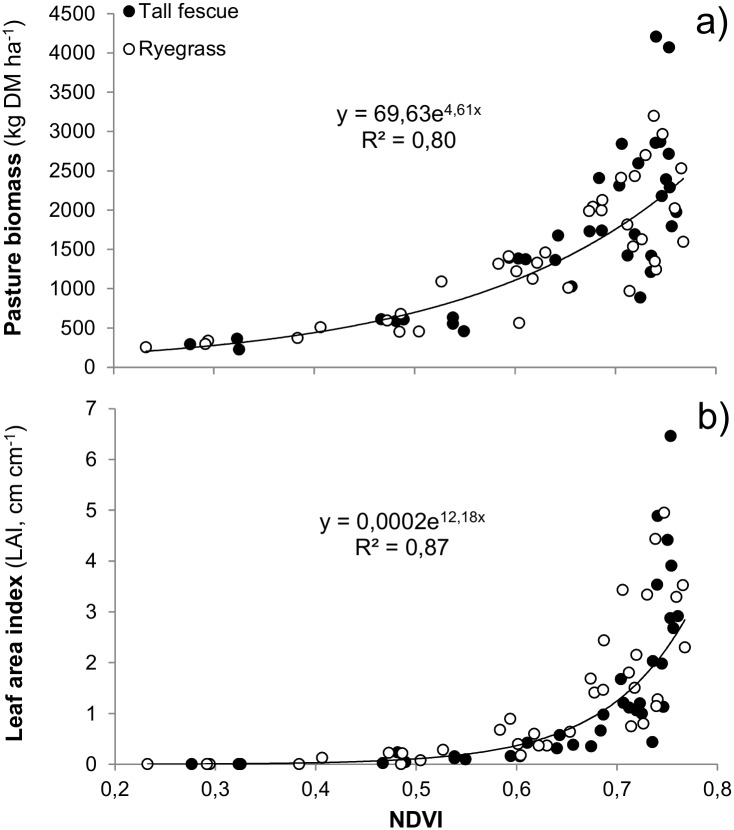
UAV calibration.Relationship among UAV-remotely sensed NDVI and pasture biomass (a) and leaf area index (b) in georeferenced plots of tall fescue- (black) and ryegrass-based (white) pasture plots (n = 72) in Exp. 1.